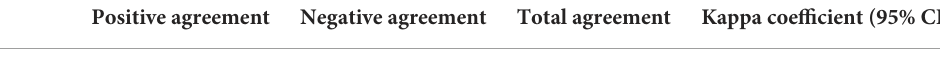
TABLE 2 Comparison of rotavirus detection results by AlphaLISA, ICA, and RT-qPCR.